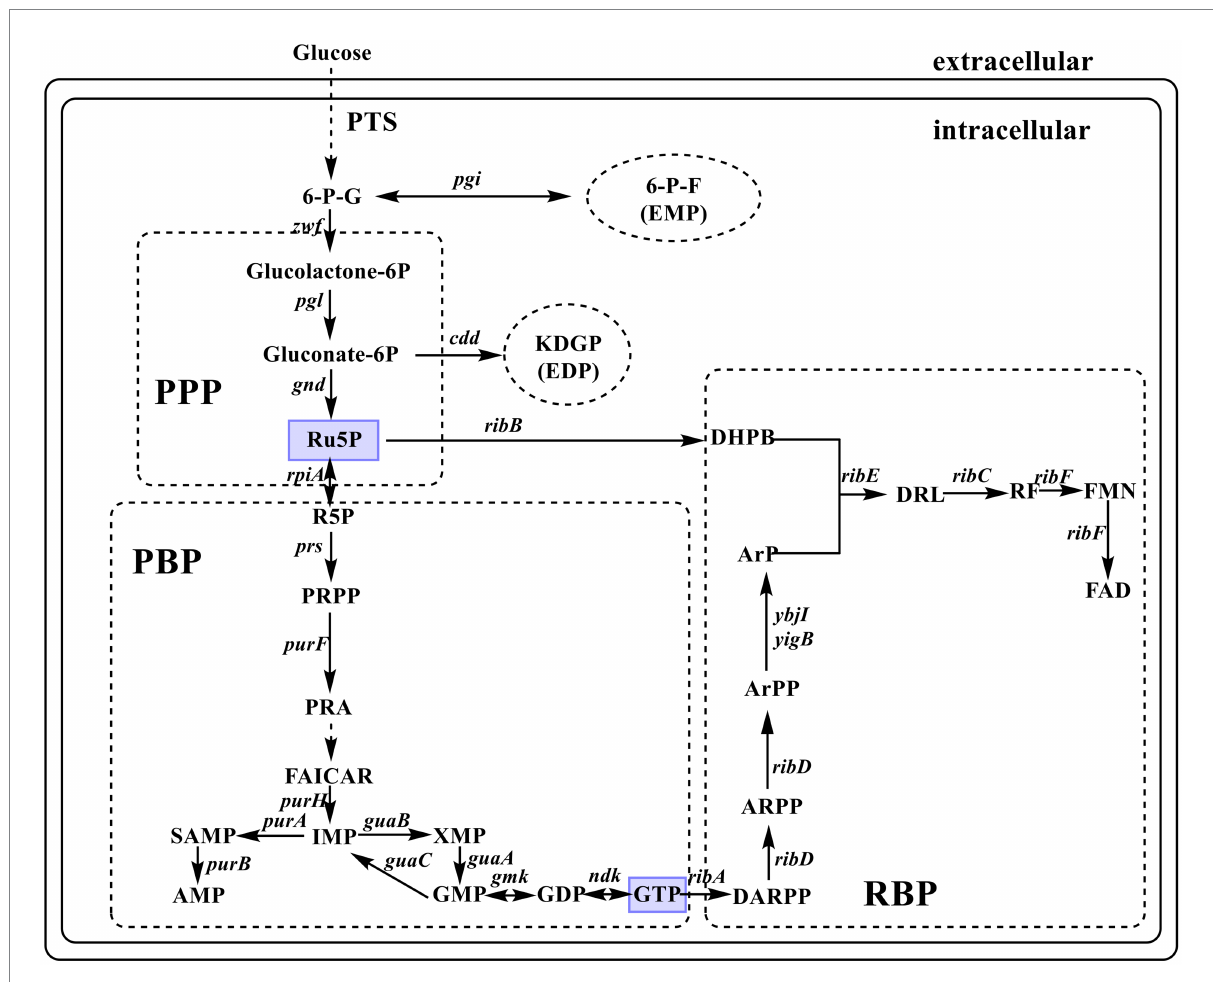
FIGURE 1 Diagrammatic representation of de novo biosynthesis of riboflavin (RF) in Escherichia coli. The enzymes encoded by the indicated genes are: zwf , glucose-6-phosphate-1-dehydrogenase; pgi , phosphoglucose isomerase; pgl , 6-phosphogluconolactonase; edd , phosphogluconate dehydratase; gnd , 6-phosphogluconate dehydrogenase; rpiA , ribose-5-phosphate isomerase A; prs , ribose-phosphate diphosphokinase; purF , amidophosphoribosyltransferase; purH , bifunctional AICAR transformylase/IMP cyclohydrolase; purA , adenylosuccinate synthase; purB , adenylosuccinate lyase; guaA , GMP synthase; guaB , IMP dehydrogenase; guaC , GMP reductase; gmk , guanylate kinase; ndk , nucleoside diphosphate kinase; ribA , GTP cyclohydrolase II; ribB , 3,4-dihydroxy-2-butanone-4-phosphate synthase; ribC, riboflavin synthase; ribD , bifunctional deaminase/reductase; ribE , 6,7-dimethyl-8-ribityllumazine synthase; ybjI and yigB , 5-amino-6-(5-phospho-D-ribitylamino) uracil phosphatase; ribF , bifunctional riboflavin kinase/FMN adenylyltransferase. PTS, phosphoenolpyruvate–carbohydrate phosphotransferase system; 6-G-P, D-glucose 6-phosphate; 6-P-F, D-fructose 6-phosphate; KDGP, 2-dehydro-3-deoxy-D-gluconate 6-phosphate; Ru5P, D-ribulose 5-phosphate; R5P, D-ribose 5-phosphate; PRPP, 5-phospho- α -D-ribose-1-diphosphate; PRA, 5-phosphoribosylamine; FAICAR, 5-formamido-1- (5-phospho-D-ribosyl)-imidazole-4-carboxamide; IMP, inosine 5 ′ -monophosphate; SAMP, N 6 -(1,2-dicarboxyethyl) AMP; AMP, adenosine 5 ′ -monophosphate; XMP, xanthosine 5 ′ -monophosphate; GMP, guanosine 5 ′ -monophosphate; GTP, guanosine 5 ′ -triphosphate; DARPP, 2,5-diamino-6-(5-phospho-D-ribosylamino)pyrimidin-4(3H)-one; ARPP, 5-amino-6-(5 ′ -phosphoribosylamino)uracil; ArPP, 5-amino-6-(5 ′ - phospho-D-ribitylamino)uracil; ArP, 5-amino-6-(1-D-ribitylamino)uracil; DHPB, 3,4-dihydroxy-2-butanone-4-phosphate; DRL, 6,7-dimethyl-8-(1- D-ribityl)lumazine; FMN, flavin mononucleotide; FAD, flavin adenine dinucleotide; EDP, Entner–Doudoroff pathway; EMP, glycolytic pathway; PPP, pentose phosphate pathway; PBP, purine biosynthesis pathway; RBP, riboflavin biosynthetic